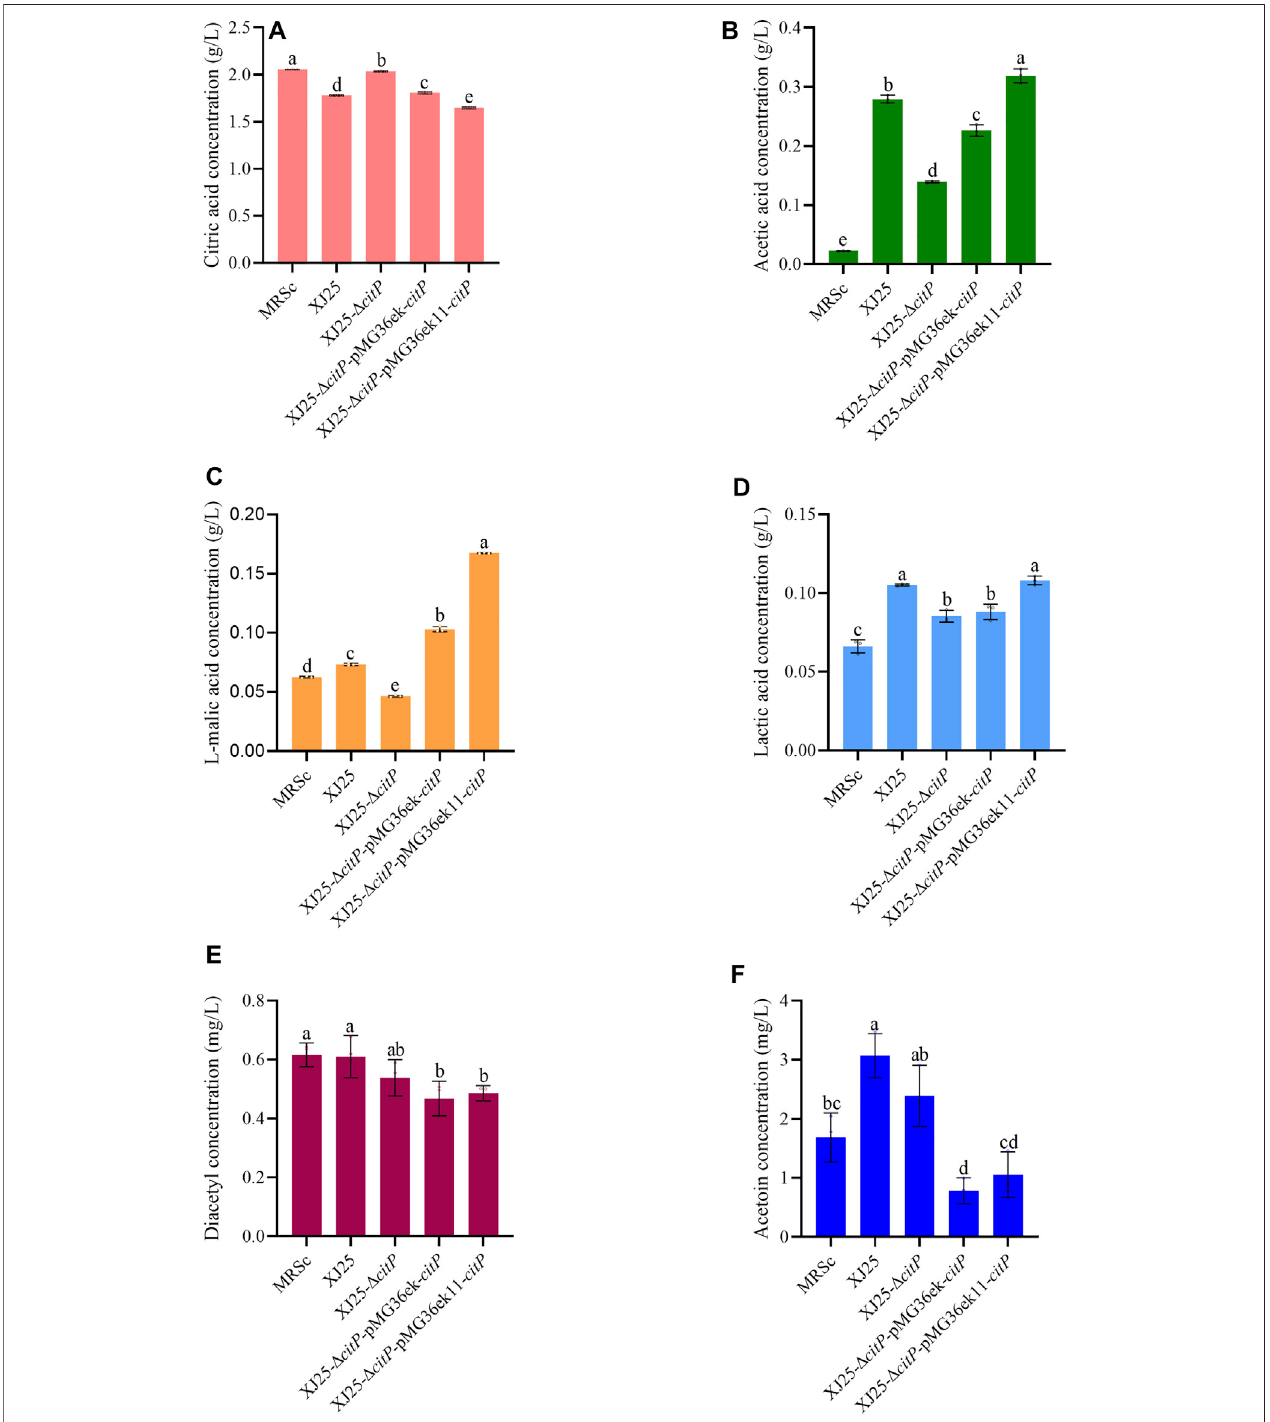
FIGURE 3 | Changes in metabolite concentration in the MRSc medium after 24 h culture with the wild-type and the mutants (A) citric acid, (B) acetic acid, (C) L-malicacid, (D) lacticacid, (E) diacetyland (F) acetoin.Dataareexpressedasmean±standarddeviation( n =3).a-emeanswithdifferentlower-caselettersinthesame row indicate signi fi cant differences ( p <